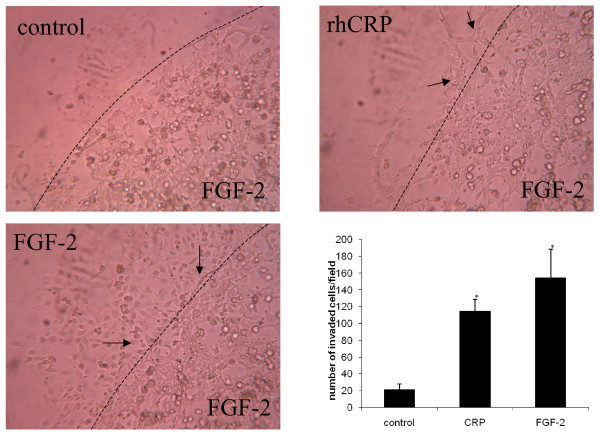
3D-matrigel invasion assay in control, FGF-2 (25 ng/ml)(arrows) and CRPdt (1 μg/ml)(arrows). Dotted line marks the interface between the first and the second layer of the matrigel.